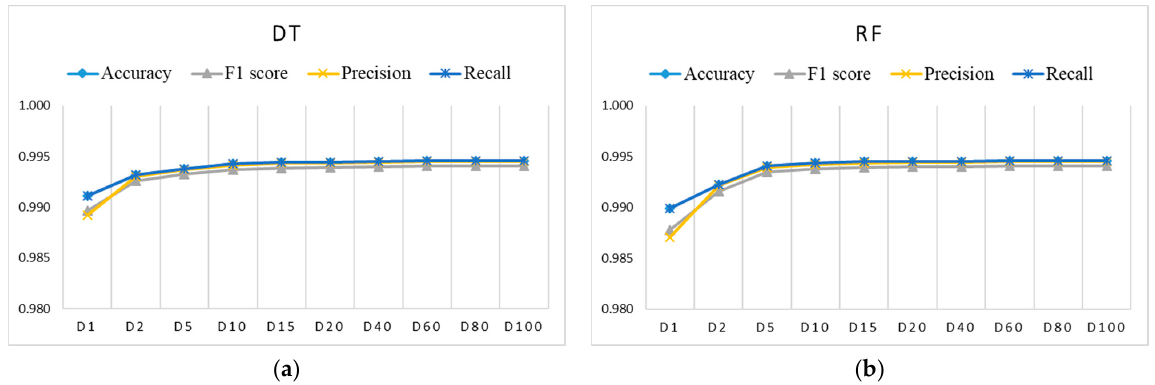
Figure 7. Evaluation results for imbalanced training datasets Di using: ( a ) DT (coincidence of accuracy, recall, and precision only for datasets larger than D1); ( b ) RF (coincidence of accuracy, recall, and precision only for datasets larger than D1).